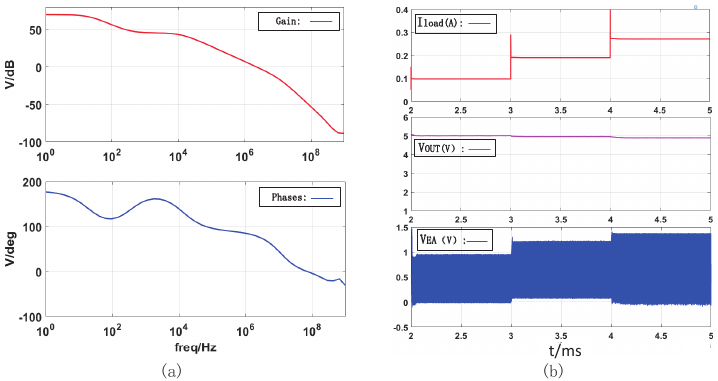
Figure 6. The structure of the error amplifier containing H-clamp and L-clamp.